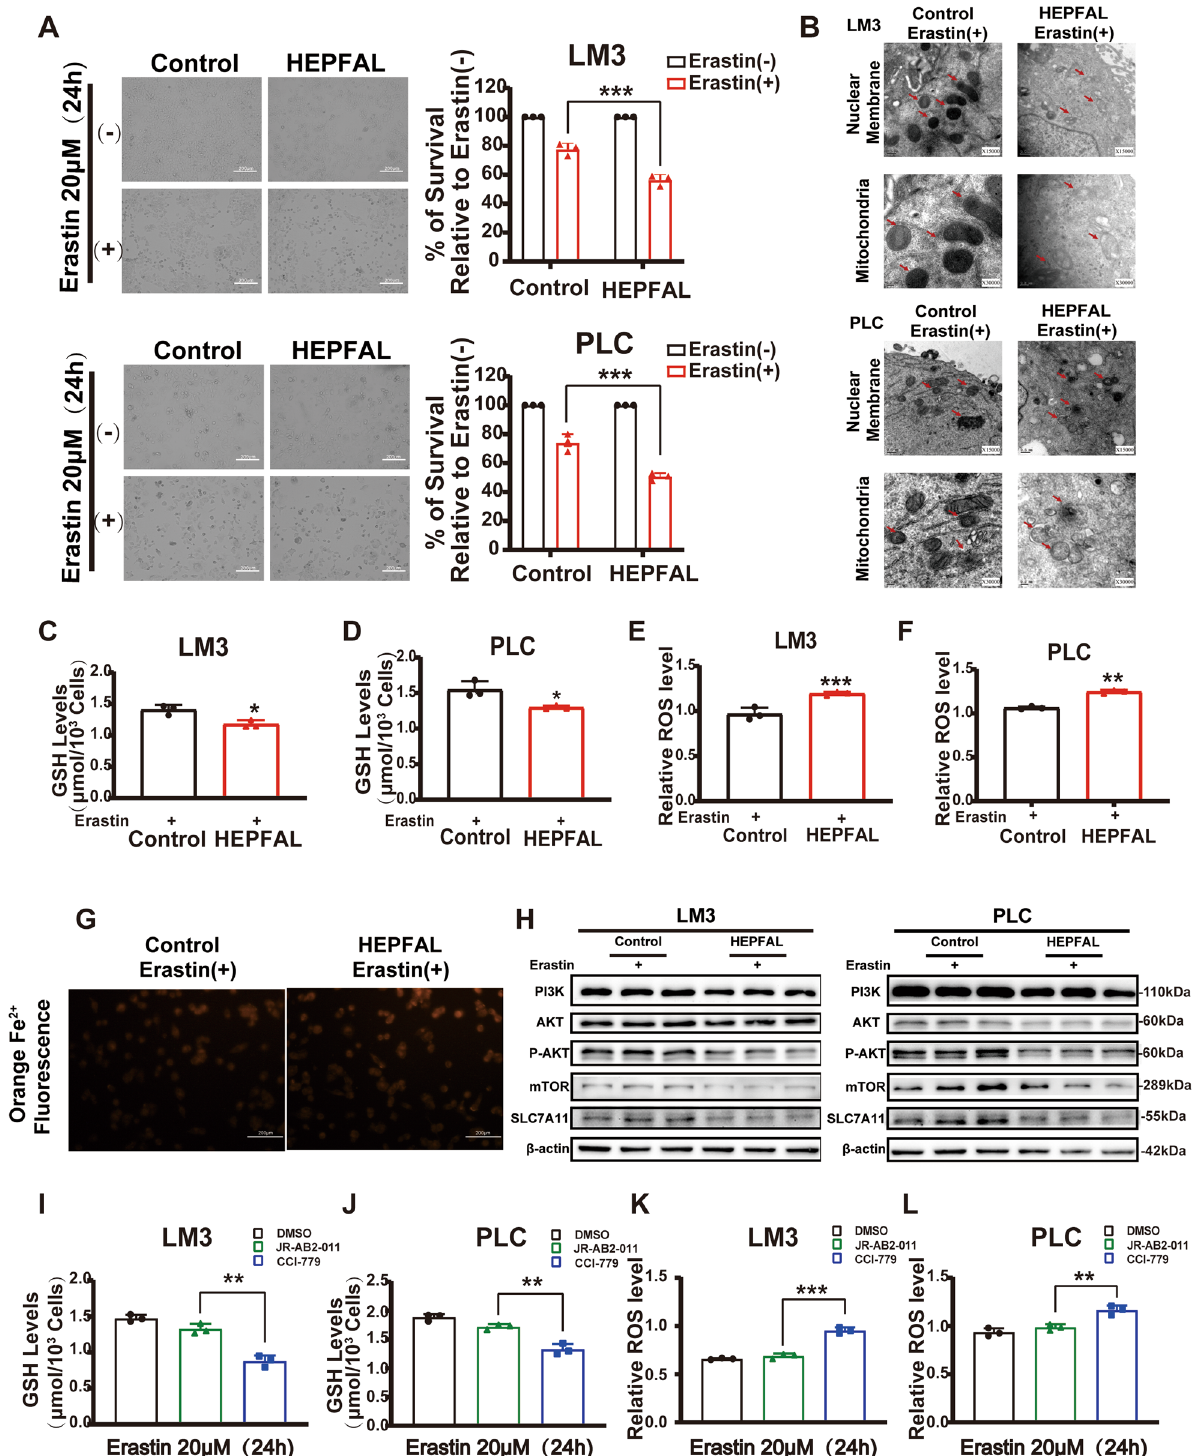
Fig. 4 Overexpression of lncRNA HEPFAL increases the sensitivity of erastin-induced ferroptosis. A HCCLM3 and PLC cells transfected with lncRNA HEPFAL expression vector or control vector were treated with 20 μ M erastin or untreated for 24 h and counted the surviving cells. B HCCLM3 and PLC cells were transfected with lncRNA HEPFAL expression vector and control vector treated with 20 μ M erastin and were subjected to transmission electron microscopy. Representative images are shown. C , D Intracellular GSH levels were examined in HCCLM3 and PLC cells treated as ( A ). E , F FACS detected ROS levels in HCCLM3 and PLC cells treated as ( A ). G HCCLM3 cells stably overexpressing lncRNA HEPFAL were treated with 20 μ M erastin to visualize the intracellular Fe 2 + ions generation using the Fe 2 + ions fl uorescent probe Ferrorange. H Western blot analysis of PI3K, AKT, P-AKT, mTOR, SLC7A11, and GPX4 protein level in HCCLM3 and PLC cells transfected with lncRNA HEPFAL expression vector and control vector treated with 20 μ M erastin. I , J Intracellular GSH levels were examined in HCCLM3 and PLC cells treated with DMSO, JR-AB2-011, and CCI-779. K , L FACS detected ROS levels in HCCLM3 and PLC cells treated as ( I , J ). * P < 0.05, ** P < 0.01, *** P <